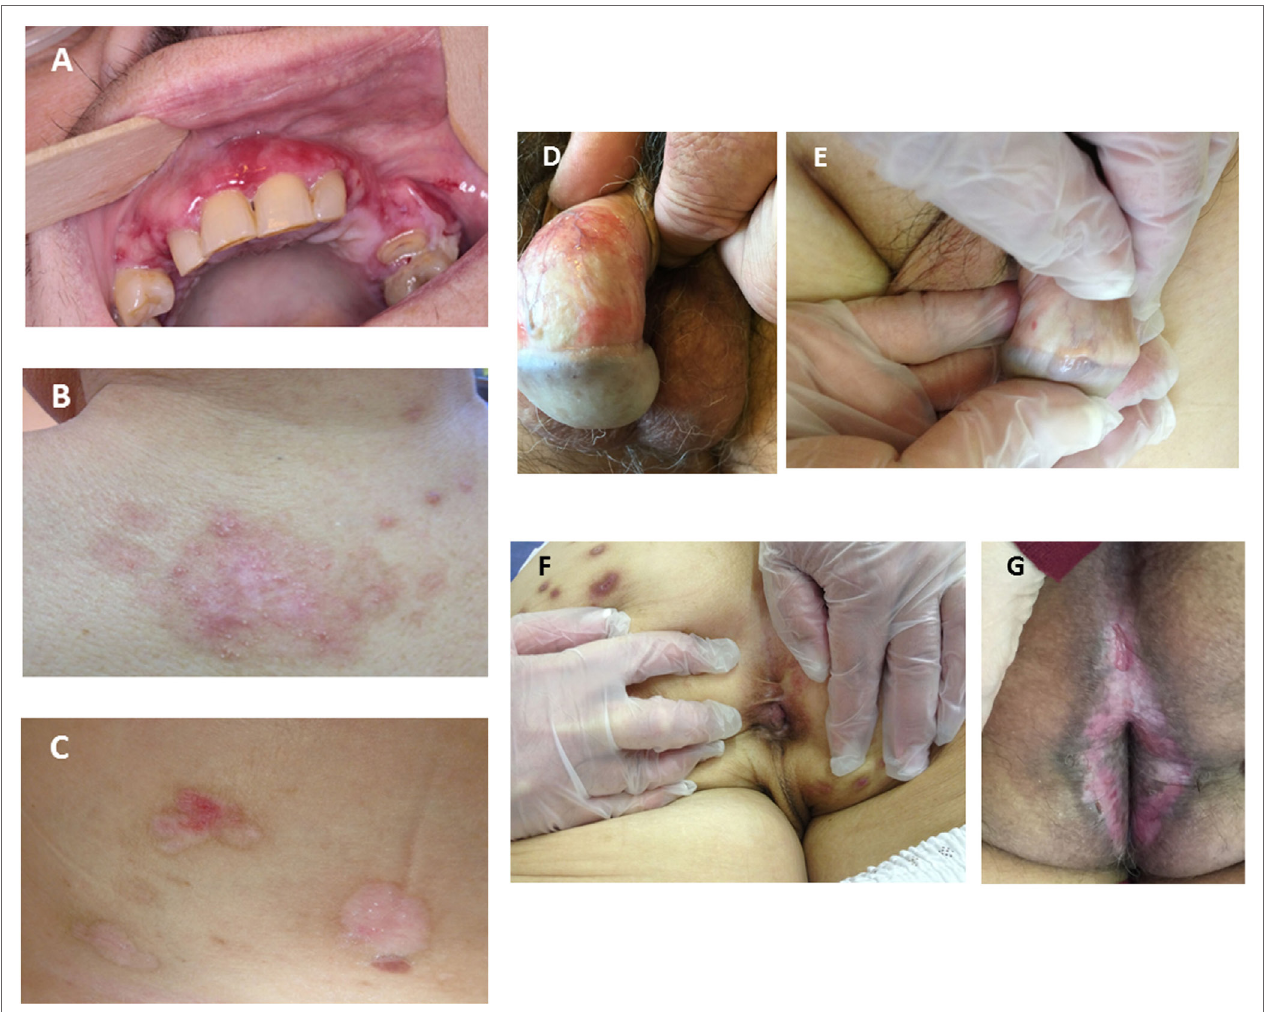
FigUre 3 | Typical patterns and locations of active and cicatricial mucous membrane pemphigoid lesions in patients 10 (a) , 13 (b,e,F) , 16 (c) , 8 (D) , and 3 (g) . (a) Active buccal mucosa lesions: erosions covered by pseudomembranes or yellowish slough, surrounded by inflammatory erythema. (b) Cicatricial cutaneous lesions: atrophic scars and milia on the upper back. (c) Active and cicatricial lesions: post-bullous erosion and atrophic scars on the breast. (D) Post-bullous erosions and synechiae between the prepuce and the glans penis. (e) Disappearance of the balanopreputial furrow. (F) Synechiae in perianal area and atrophic scars on the skin. (g) Perianal linear erosion and atrophic